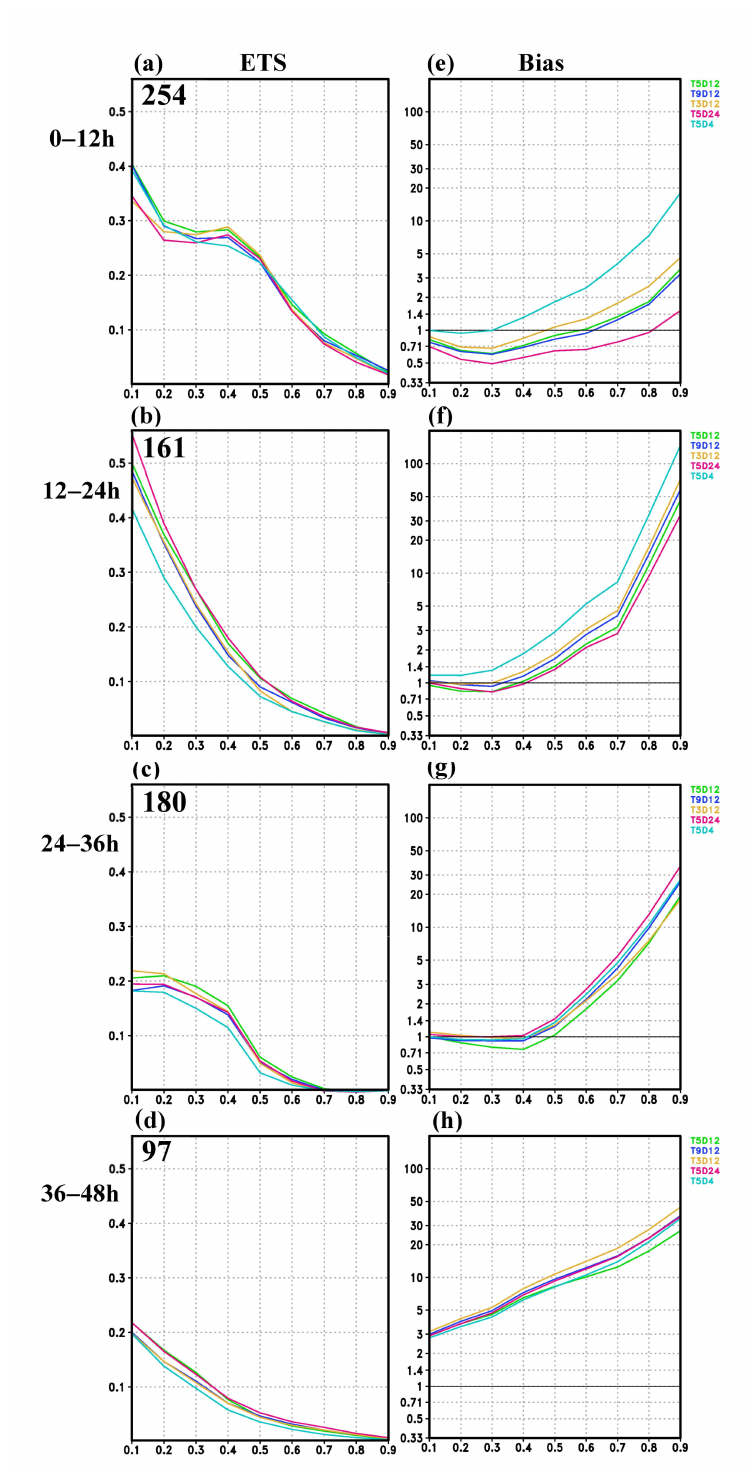
Figure 11. Same as Figure 6 but for T9D12 (blue), T3D12 (yellow), T5D24 (magenta), and T5D4 (cyan). The ETS and bias of T5D12 (green), which are the same as in Figure 6, are also shown for comparison. The time periods are ( a , e ) 0–12 h, ( b , f ) 12–24 h, ( c , g ) 24–36 h, and ( d , h ) 36–48